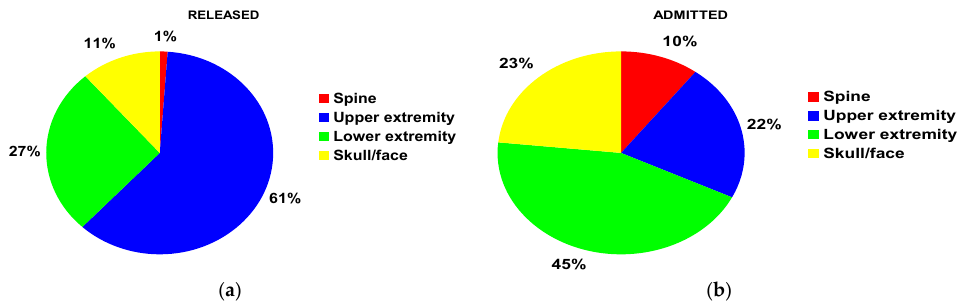
Figure 1. Fracture distribution by major anatomic location: ( a ) for those patients treated and released from the ED; ( b ) for those patients admitted to the hospital from the ED. There were very few Asian children, children with isolated rib fractures and those having more than one fracture. Thus, we excluded Asian children, those with an isolated rib fracture, and those with more than one fracture. All the subsequent analyses were per- formed with these exclusions.